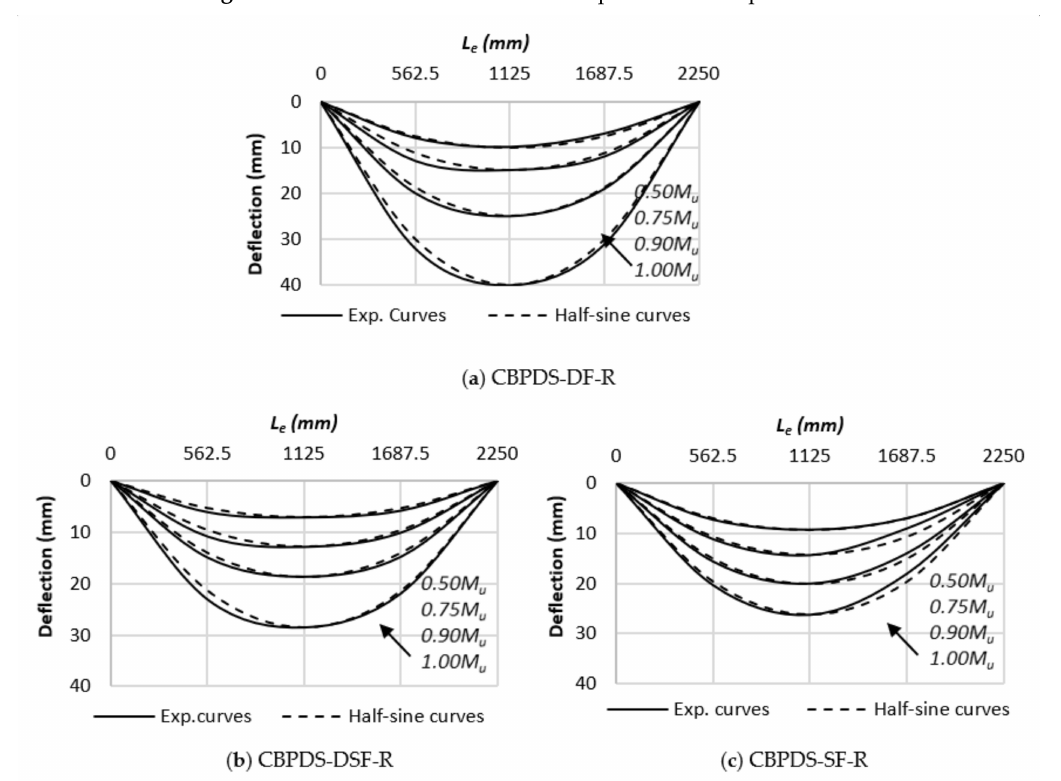
Figure 14. Deflection curves of CBPDS specimens with perpendicular PSS